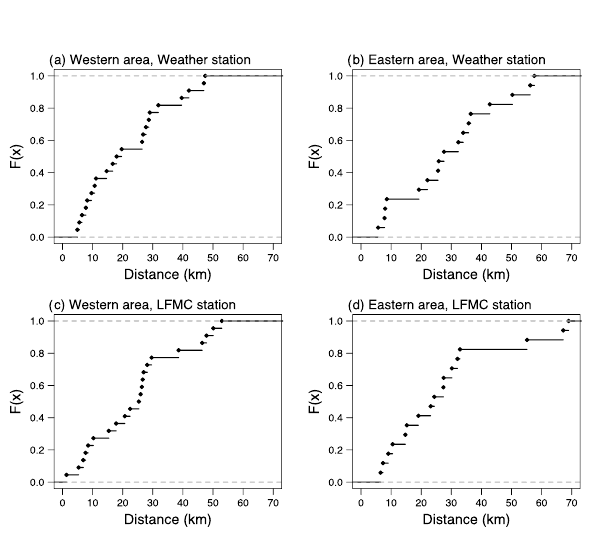
Figure 4. Cumulative distribution function of the distance between large fires and the weather stations (a, c) and of the distance between large fires and the live fuel moisture content (LFMC) stations (b, d)